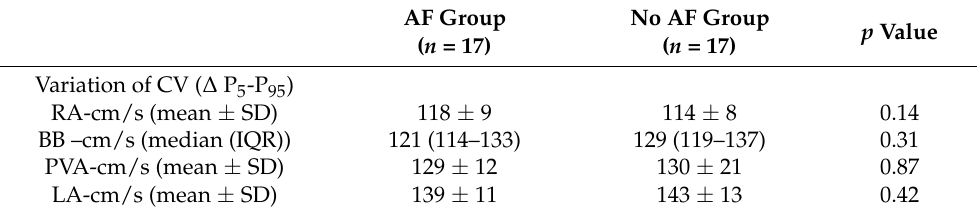
Table 2. Variation of CV.